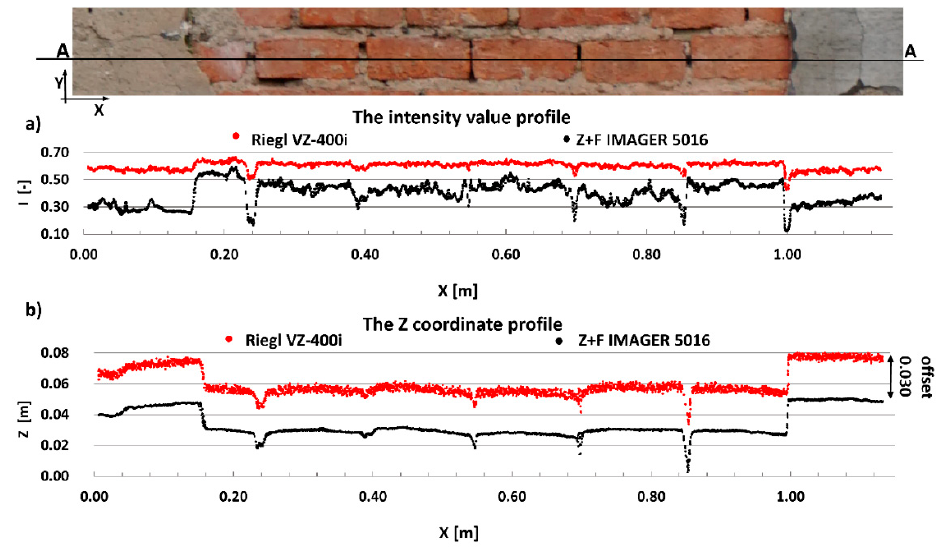
Figure 4. AA profiles—brick wall with damaged plaster: ( a ) intensity data profile and ( b ) geometric data profile.